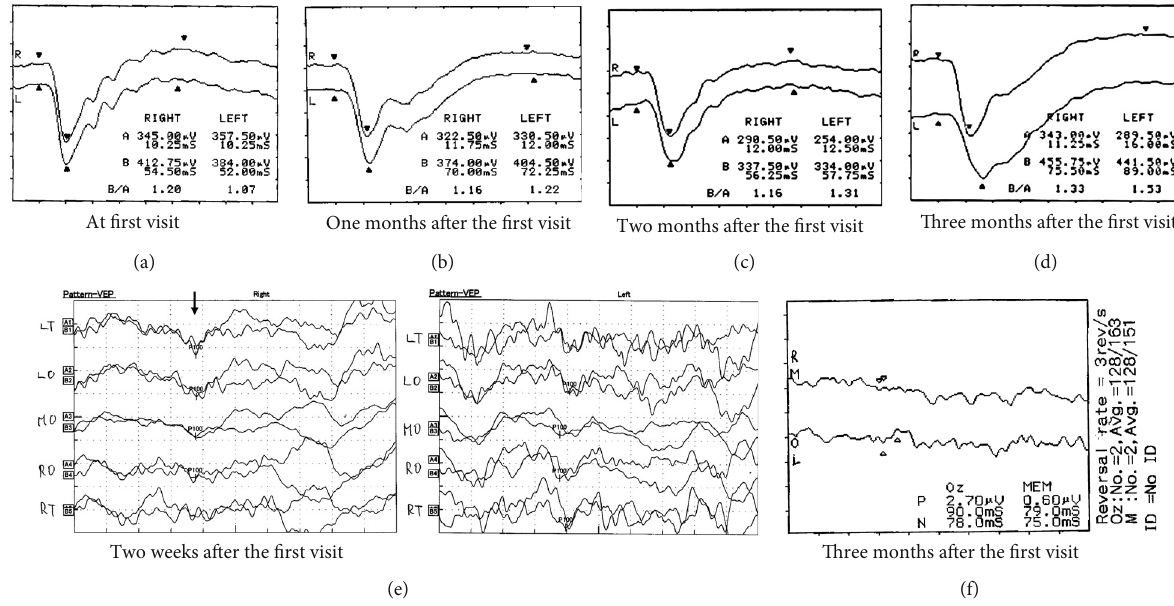
Figure 4: Dark-adapted single- fl ash electroretinograms (ERG) and pattern visual evoked potential (VEP) fi ndings. (a) At the fi rst visit, ERG showed normal amplitudes in both eyes (BE). (b) One month after the fi rst visit, ERG showed slightly decreased oscillatory potentials (OPs) in BE. (c) After changing the EGFR-TKI treatment, the ERG response did not change in BE two months after the fi rst visit. (d) Three months after the fi rst visit, ERG showed markedly decreased OPs in BE. (e) VEP two weeks after the fi rst visit had decreased P100 amplitudes in the midline occipital region of BE. (f) VEPs are non-recordable in